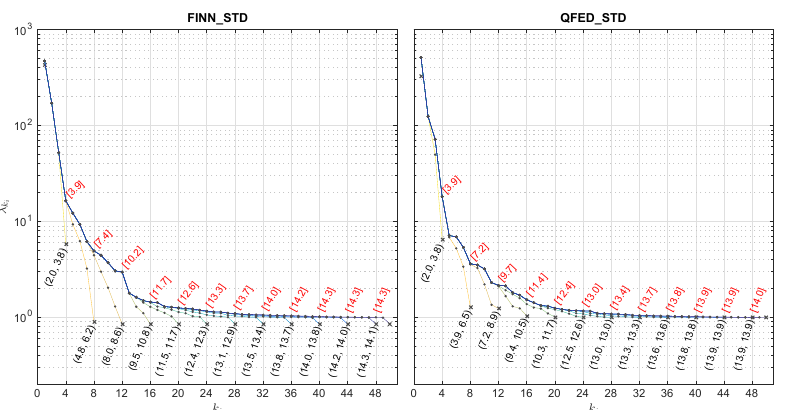
Figure 14. Eigenvalue spectra for FINN_STD and QFED_STD in the final outer loop on 22 June. The lines show the estimate of the spectrum [ λ ] in every fourth inner loop iteration, l . The black numbers in parentheses are the estimates of DOF that include eigenvalues in 1 ,...,λ k i = l the sets (converged to within 5% of the previous estimate, all available). The red numbers in brackets are the truncated estimates of DOF using the most completely converged set of eigenvalues available in the 50th